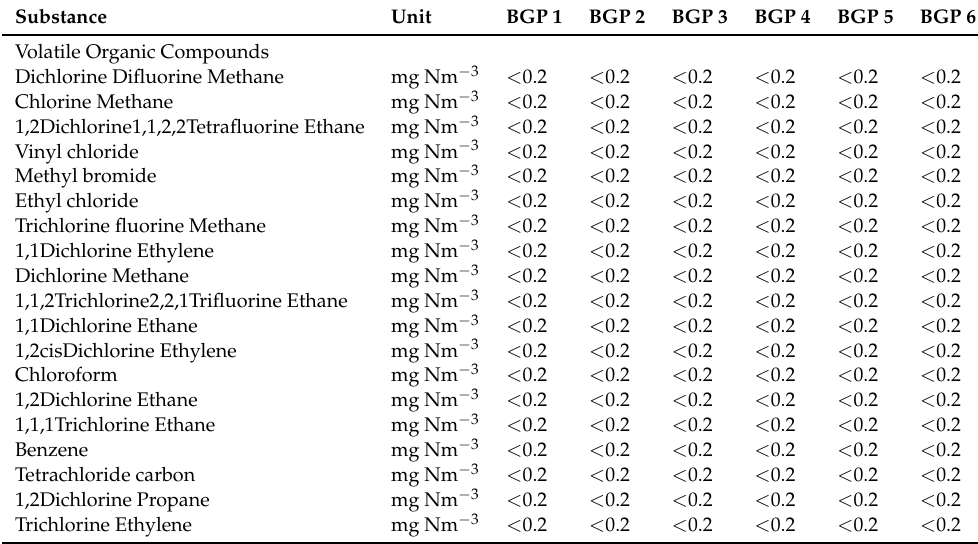
Table 11. Biogas composition—part 4.